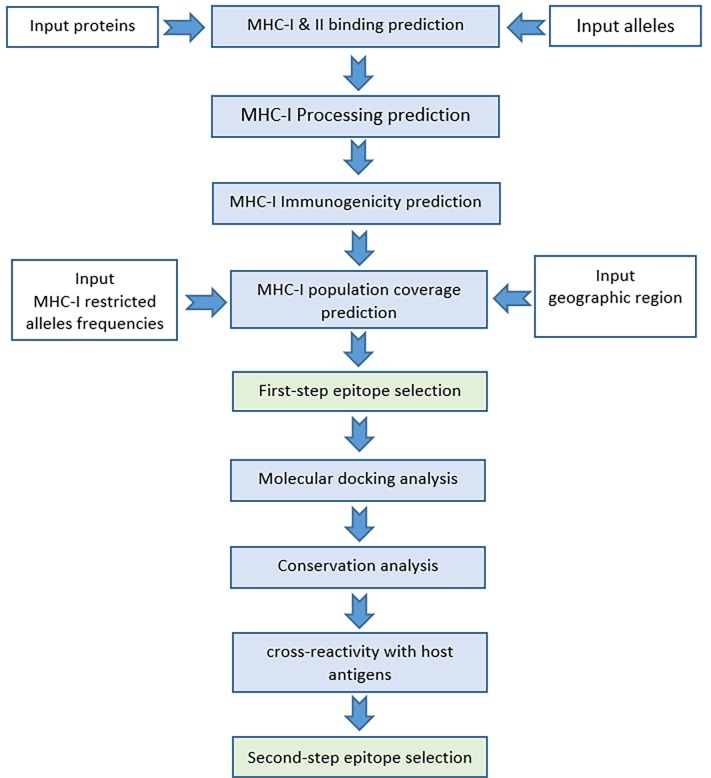
The pipeline of CABS-dock protocol: The fully automated CABS-dock procedure contains four main stages, shown in the blue boxes.